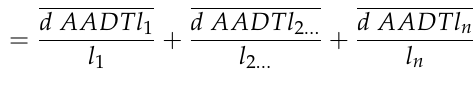
Model 8: Weighted distance (> or <4.9 km; Average length of daily trips in Norway) between counters in local index, where d = average distance between counters > 1 =